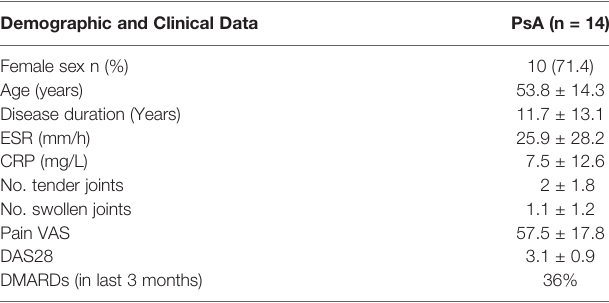
TABLE 1 | Baseline Characteristics and clinical features of PsA